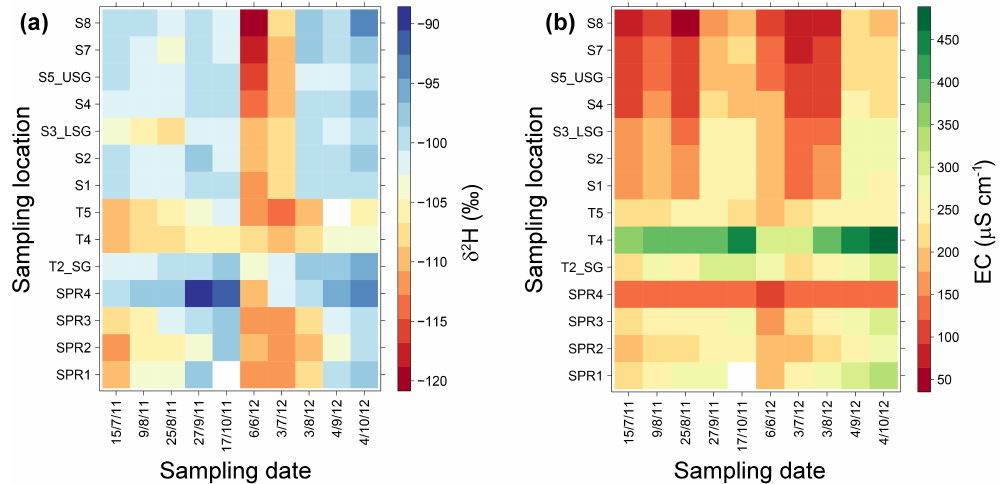
Figure 3. Spatio-temporal patterns of δ 2 H (a) and EC (b) for samples taken on the same day at all locations in 2011 and 2012. Location T1 and T3 are excluded because sampled only for 1 year. White cells indicate no available measurements. In 2013, samples were collected only at some locations (Table 1) and therefore, for consistency, 2013 data are not reported here.